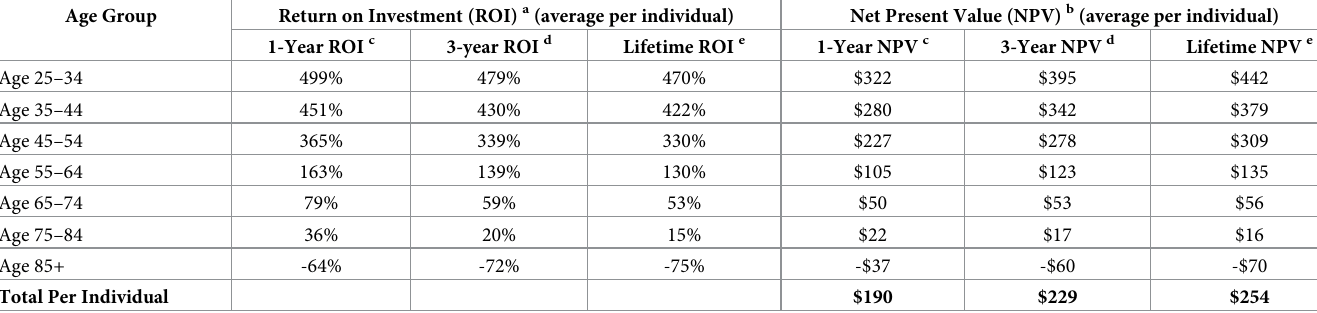
Table 1. Financial impact of SMBP (ROI, NPV) from the perspective of a private insurer. Estimates are for all use cases bundled together. Age Group